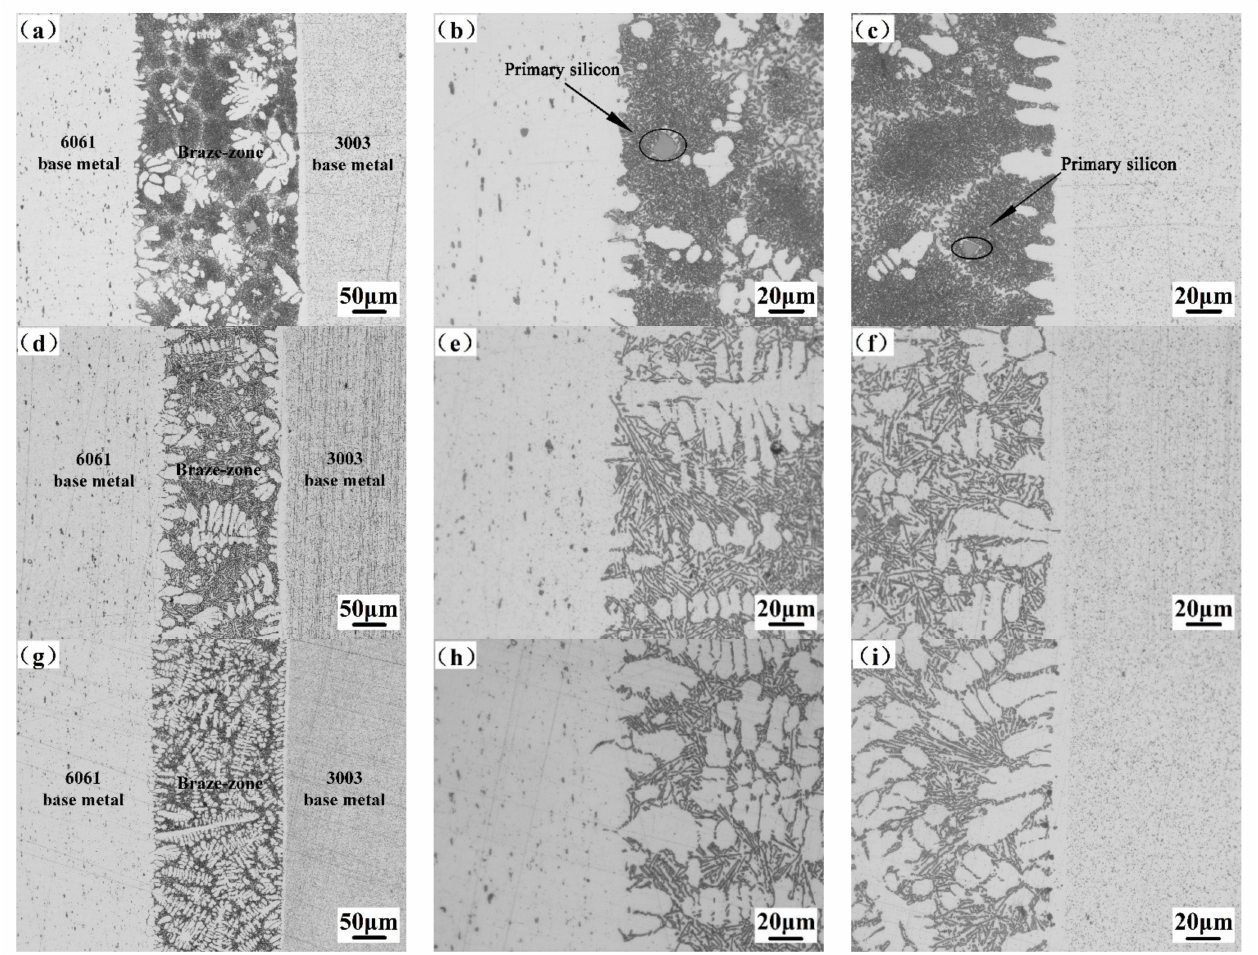
Figure 9. Microstructure of brazed joints with the different composite brazing filler metal: ( a ) SFC; ( b ) 6061-brazed seam area of ( a ); ( c ) brazed seam-3003 area of ( a ); ( d ) PM; ( e ) 6061-brazed seam area of ( d ); ( f ) brazed seam-3003 area of ( d ); ( g ) SKA; ( h ) 6061-brazed seam area of ( g ); ( i ) brazed seam-3003 area of ( g ).